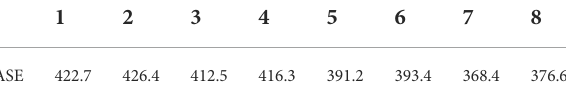
TABLE 2Computed aromaticstabilizationenergy (ASE, inkcal/mol) of molecules 1 –